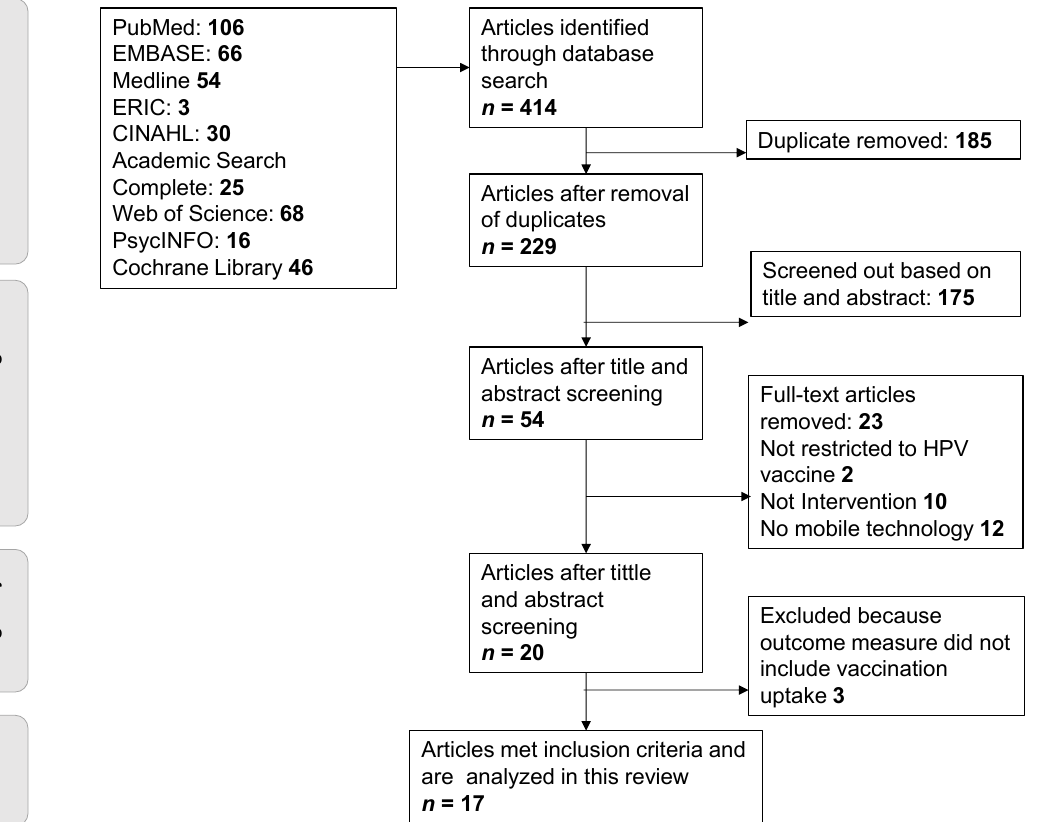
Figure 1. Flowchart of the search strategy.